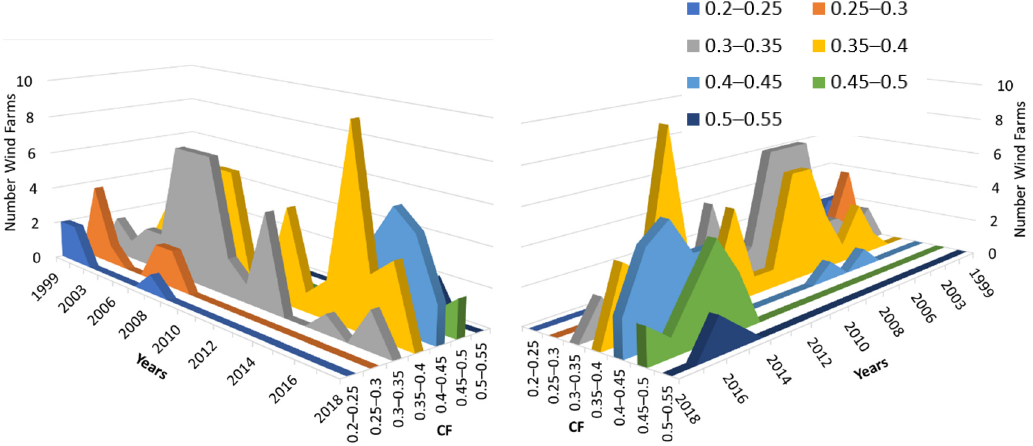
Figure 4. Yearly average capacity factor (CF) of wind farms in Texas according to the installation year, from 1999 to 2018.